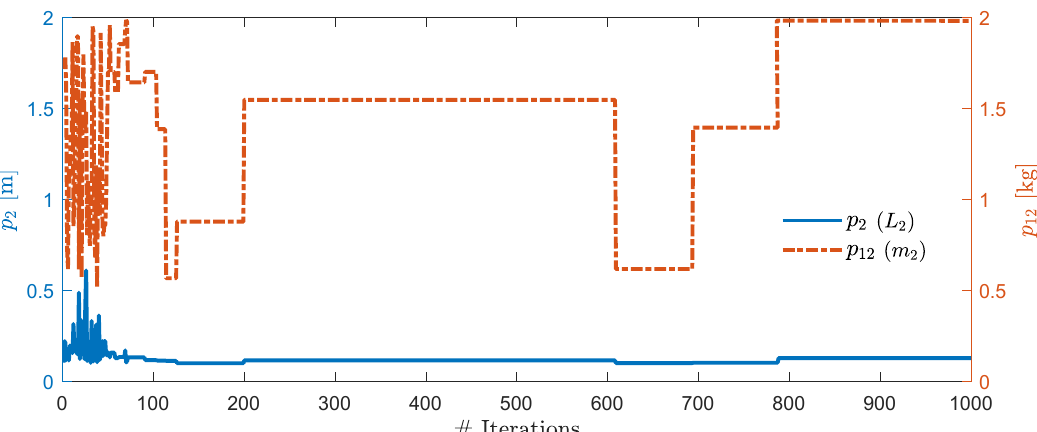
Figure 13. Computed convergence of the solving process in terms of the input link size parameter and its mass, L 2 and m 2 in Table 2 for example in Figure 7.